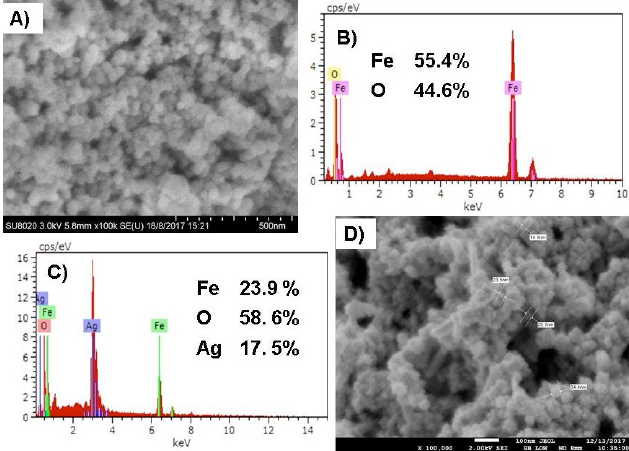
Fig. 3. Elemental composition and microphotography of Fe 3 O 4 (A and B) and AgFe (C and